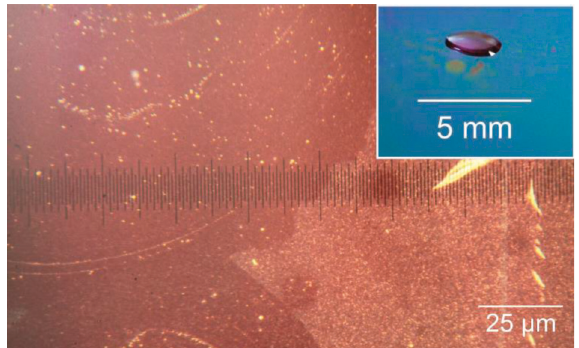
Figure 1: Photographs showing that the analyte and solvent might chemically react with the layer sequence, thus prohibiting the multiple use of the chip. Wherever droplets have touched the layers upon their actuation, surface modifications have taken place. The photograph in the inset shows a larger area of the chip under oblique observation. The droplet has been moved slightly away from the position, where it sat during an analytical run. Modified surface spots are